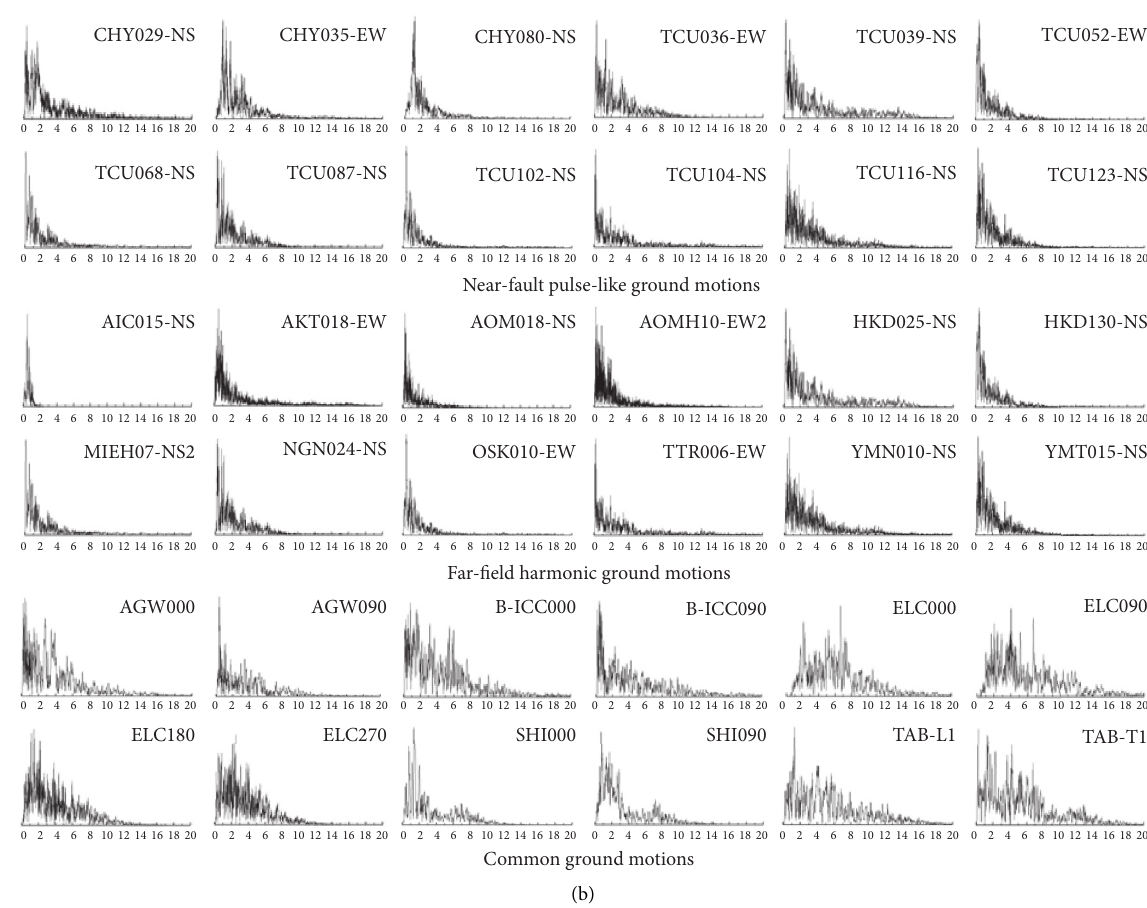
Figure 1: Basic property of partial earthquake records. (a) Acceleration time histories (s). (b) Fourier amplitude spectrum